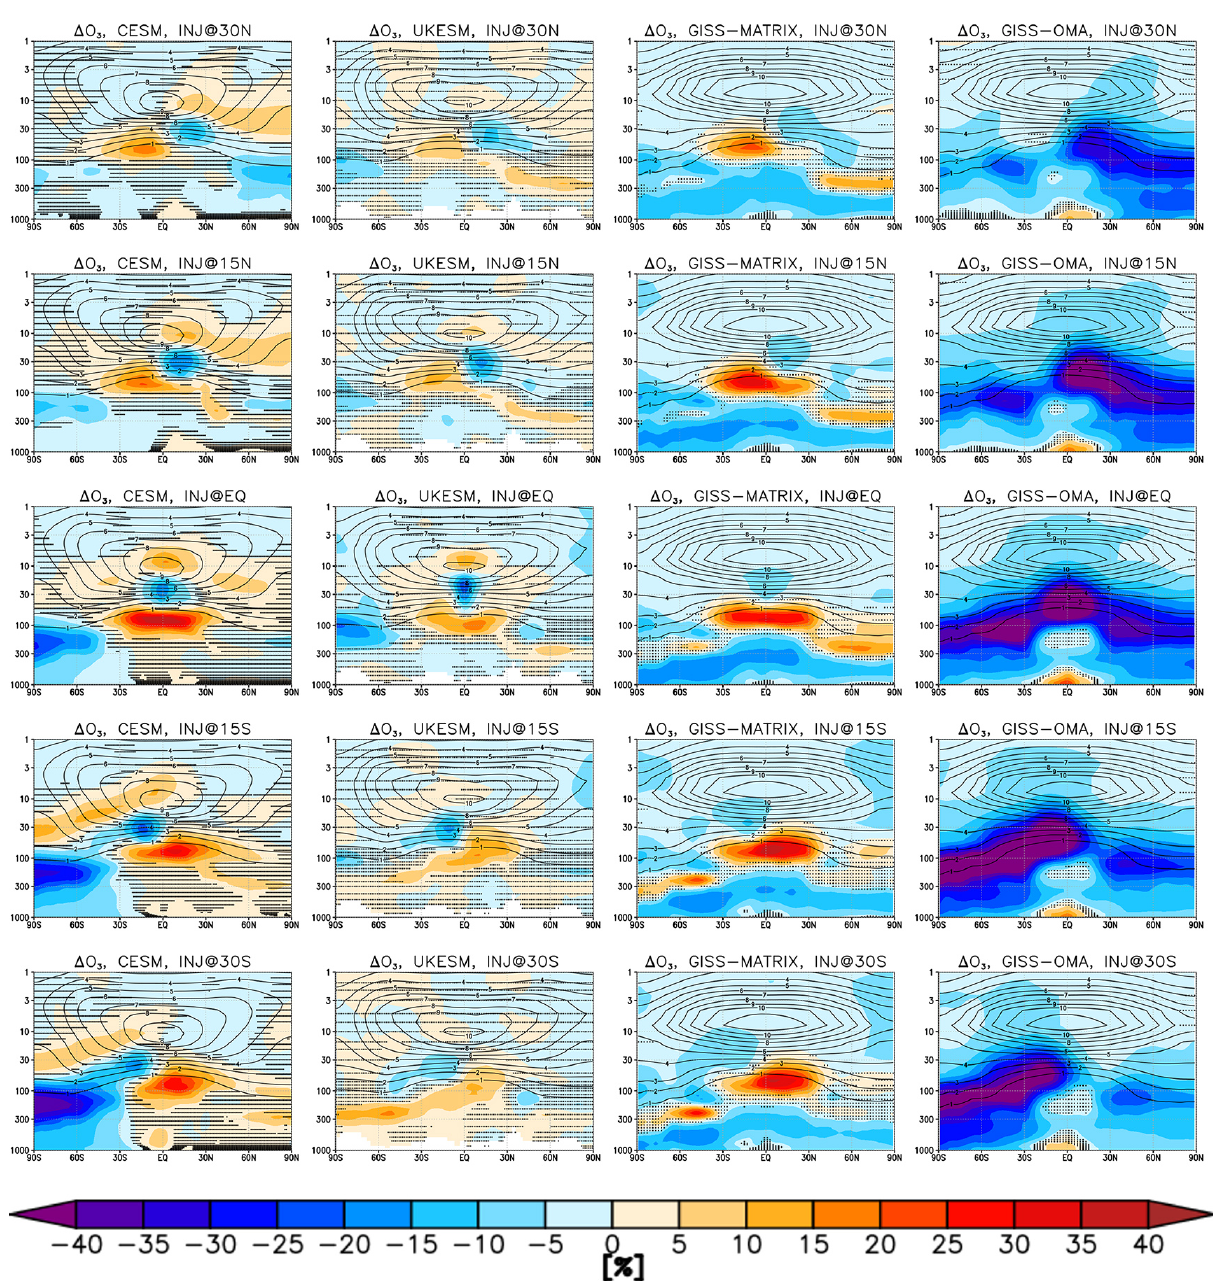
Figure 7. Shading: yearly mean changes in ozone [%] averaged over the last 8 years of the simulations compared to the same period in the SSP2–4.5 run for CESM (column 1), UKESM (column 2), GISS-MATRIX (column 3), and GISS-OMA (column 4). Contours show the ozone mixing ratios [ppmv] in the control SSP2–4.5 run for reference. Stippling as in Fig.